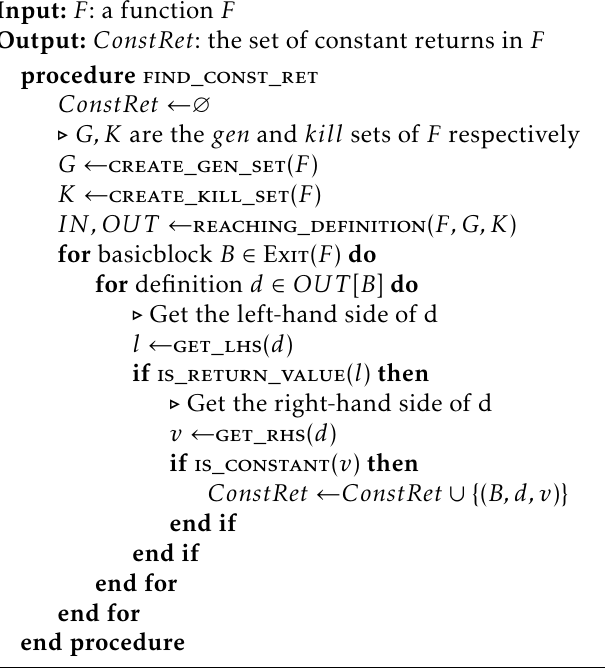
Algorithm 2 Finding constant return